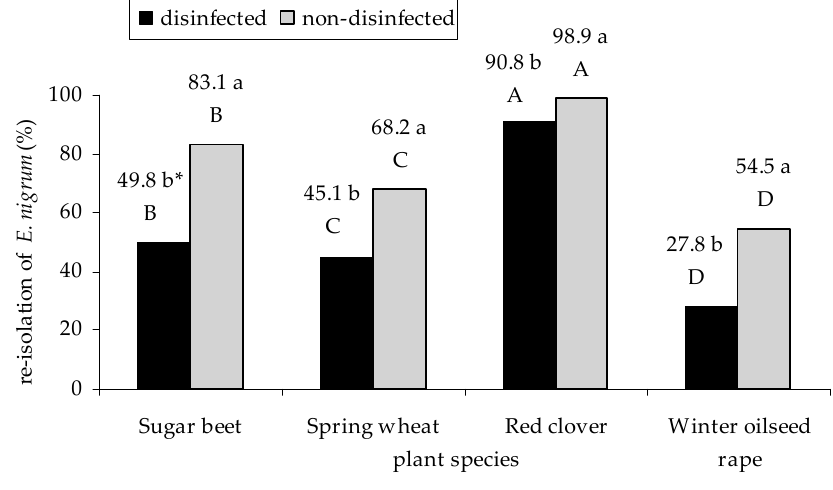
Figure 8. The percentage of E. nigrum isolates in re-isolation from infected seedlings of sugar beet ( B. vulgaris L. ssp. vulgaris ), spring wheat ( T. aestivum L.), red clover ( T. pratense L.), and winter oilseed rape ( B. napus L.). Means followed by the same letter (*) are not statistically different at the α ≤ 0.01 level, according to the Tukey HSD test. Small letters indicate the differences in the re-isolation of E. nigrum between the variants of the experiment (disinfected and non-disinfected). Capital letters indicate the differences in the re-isolation of E. nigrum between individual plants of a given variant of the experiment (disinfected and non-disinfected).